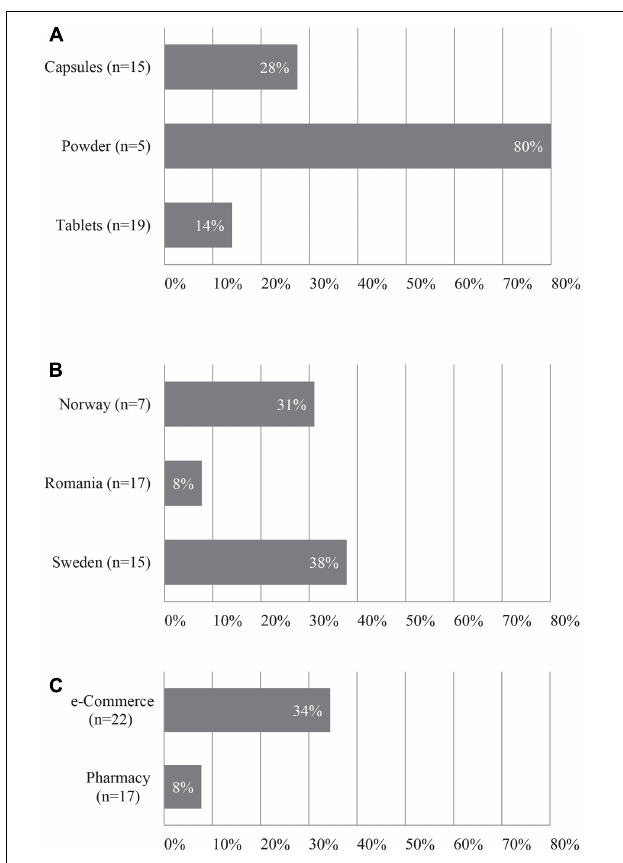
FIGURE 2 | Fidelity of herbal products (A) per product form; (B) per country; (C) per acquisition method. n = total number of herbal products.